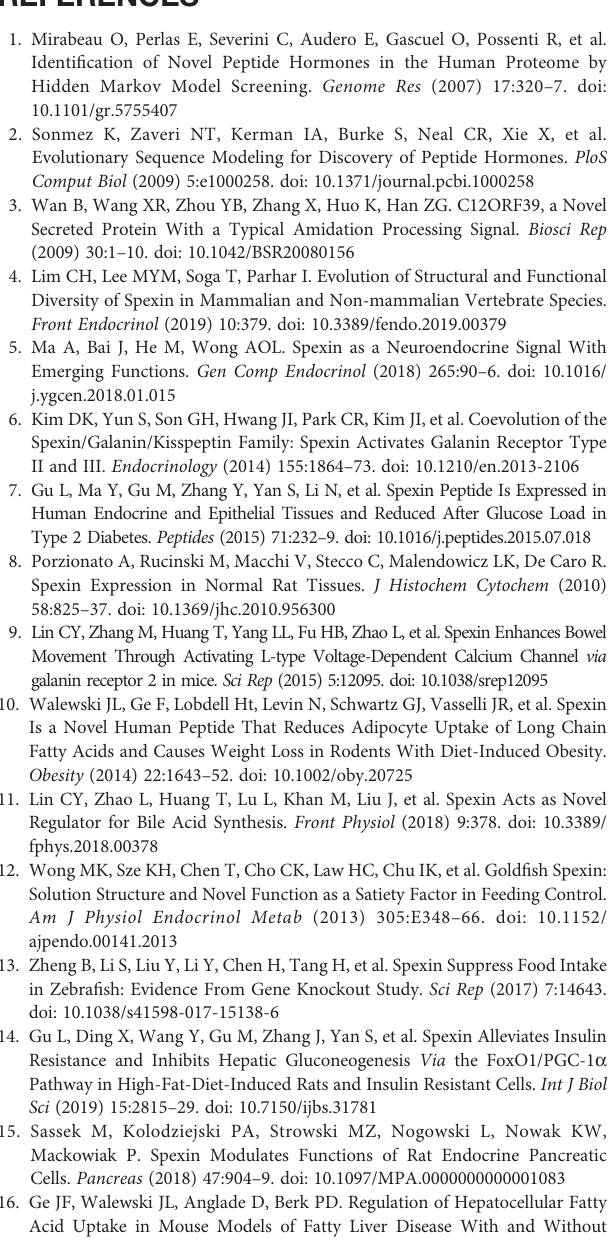
Supplementary Figure 1 | Ramachandran analysis for quality control of structural data for homology modeling of mouse GalR2 and GalR3. The Phi-Psi plots of the respective data for (A) GalR2 and (B) GalR3 reveal that all the data are withinthe mostfavoredregion(greendotswithinthe areascoveredby blueline)and additional allowed region (yellow dots within the areas covered by orange line) but